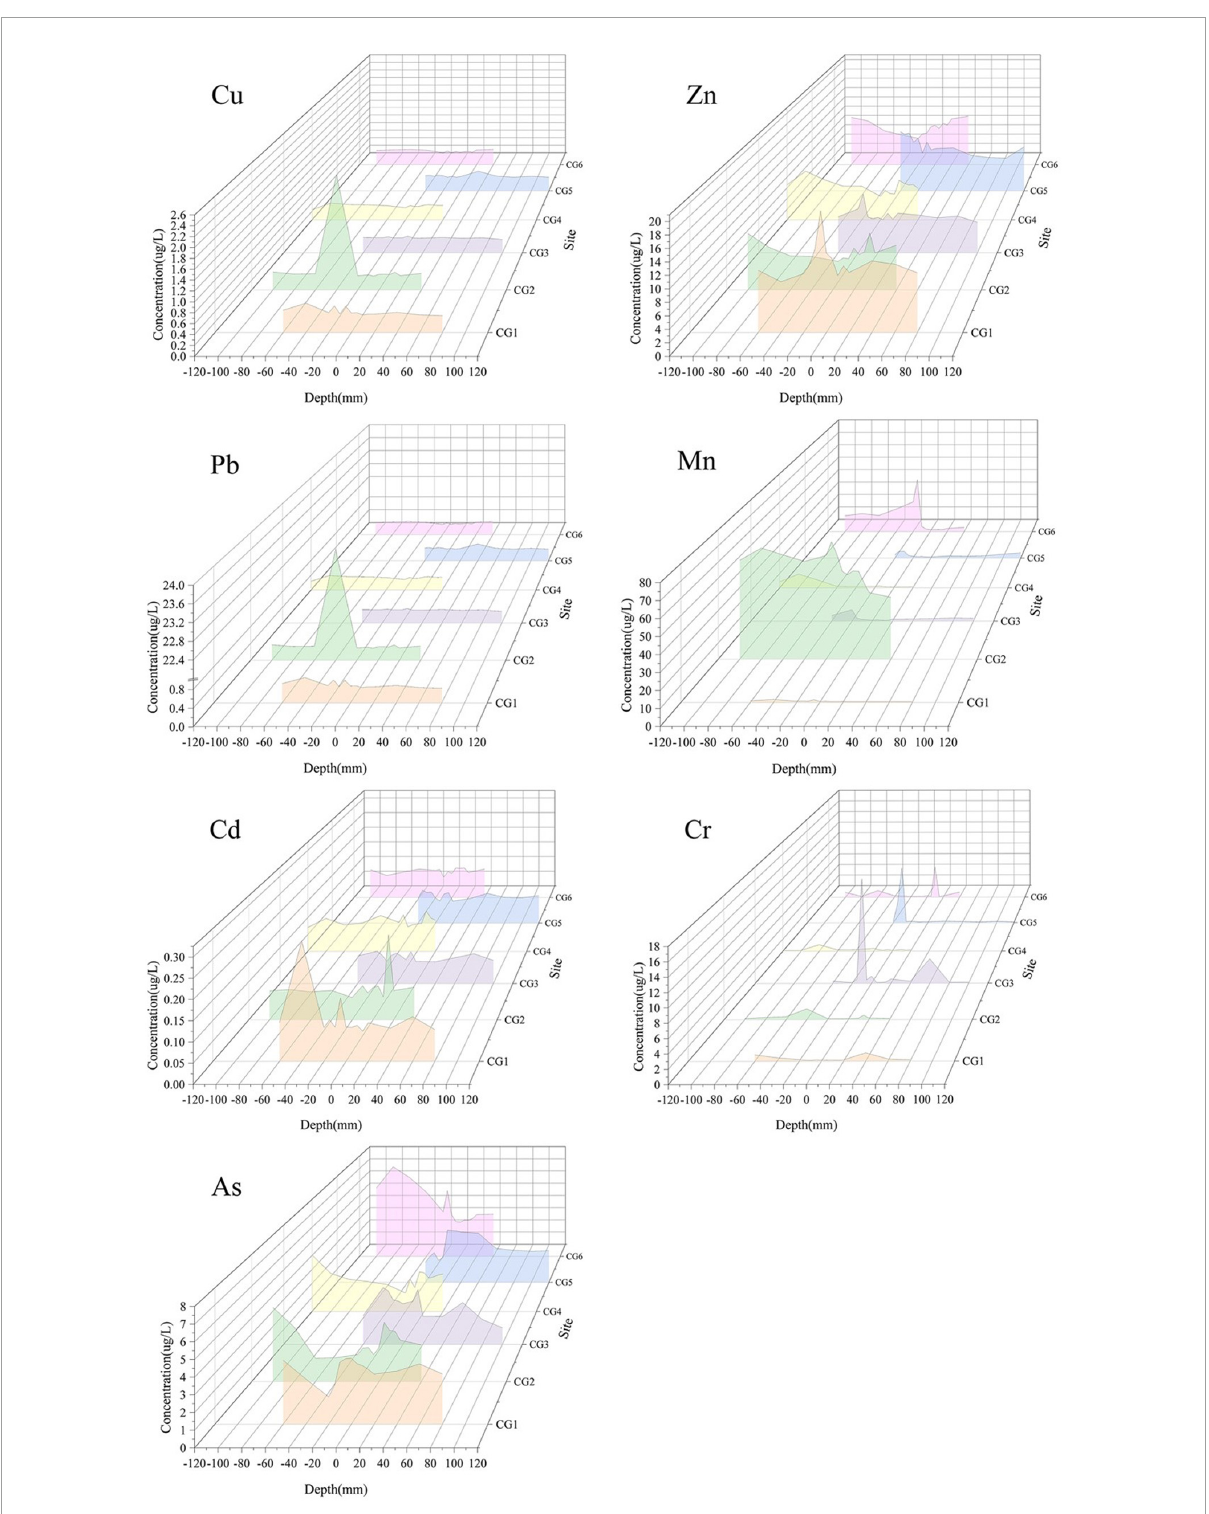
FIGURE3 The vertical distributions of labile Cu, Zn, Pb, Mn, Cd, Cr, and As at the sediment-water interface during the ice-covered period of Chagan Lake.